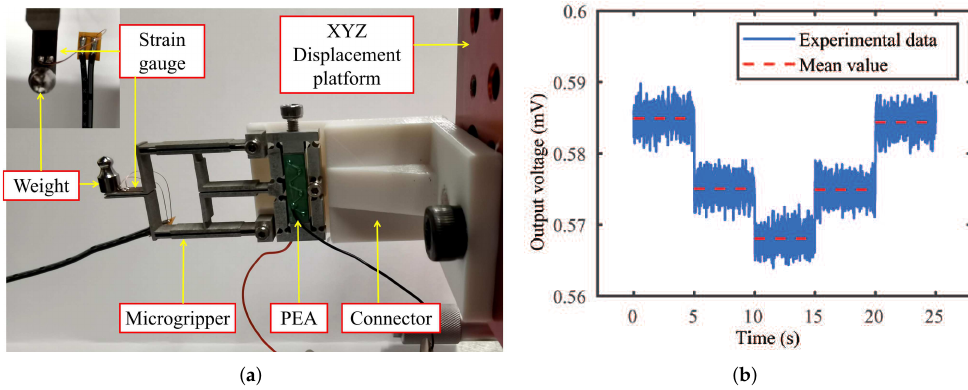
Figure 12. Experimental result of the strain-gauge force sensor test. ( a ) Calibration experiment setup and ( b ) calibration result of the force